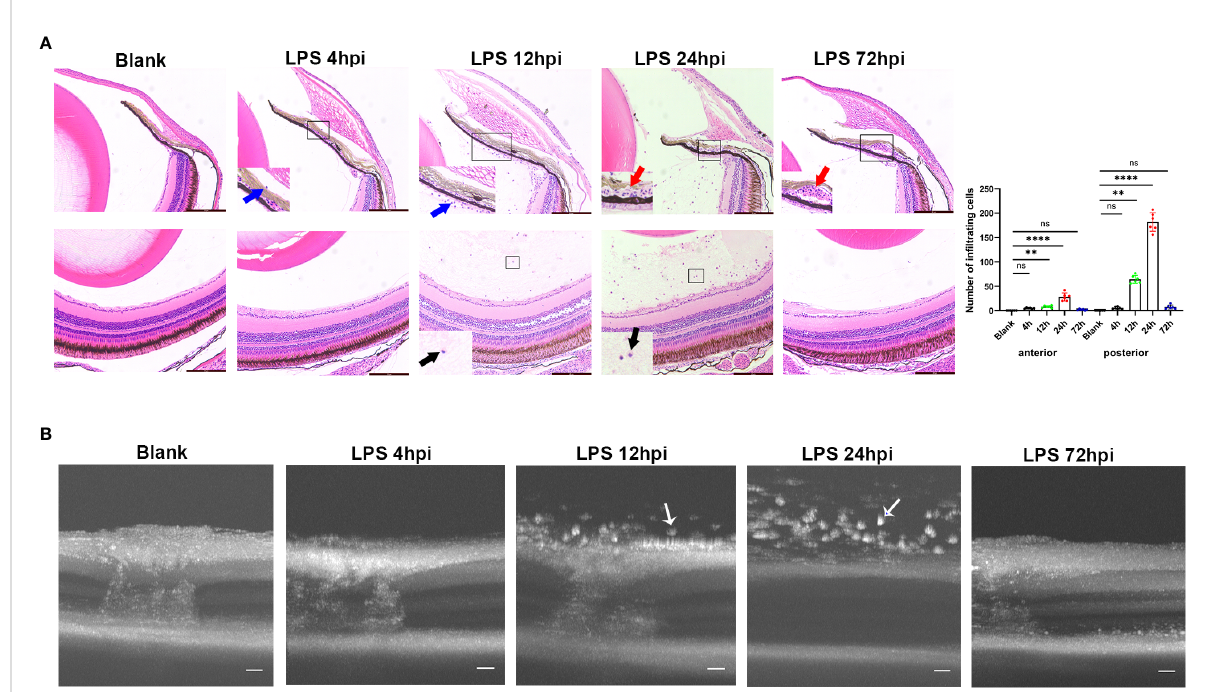
FIGURE 1 In fl ammatory sign of EIU in zebra fi sh over time-course. (A) Left, H&E staining of eyes at different time points after LPS injection. Blue arrow, in fi ltrating cells around iris. Red arrow, vascular dilation. Black arrow, vitreous in fi ltration. Scale bars = 50 m m. Right, quanti fi cation of in fl ammatory cells of anterior and posterior segments (mean ± SD; n = 6 eyes per group; ** P < 0.01, **** P < 0.0001, ns, not signi fi cant; one- way ANOVA). (B) Serial OCT imaging of EIU at various time points after LPS injection. White arrow, highly re fl ex dots. Scale bars = 20 m m. hpi, hours post